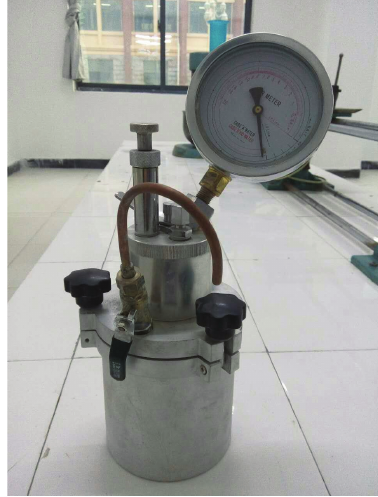
Figure 3: Mortar air content-measuring